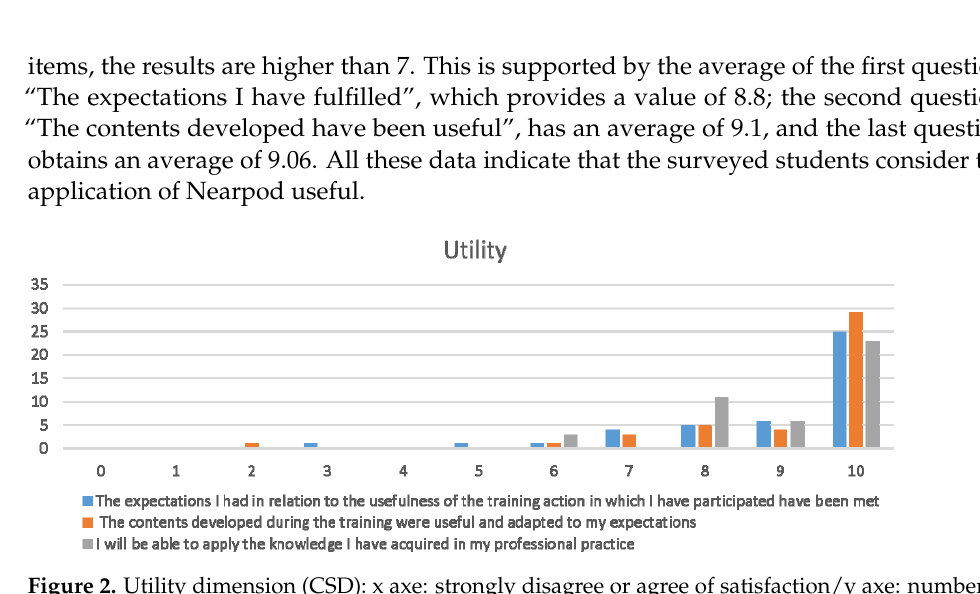
Figure 2. Utility dimension (CSD): x axe: strongly disagree or agree of satisfaction/y axe: number of responses.